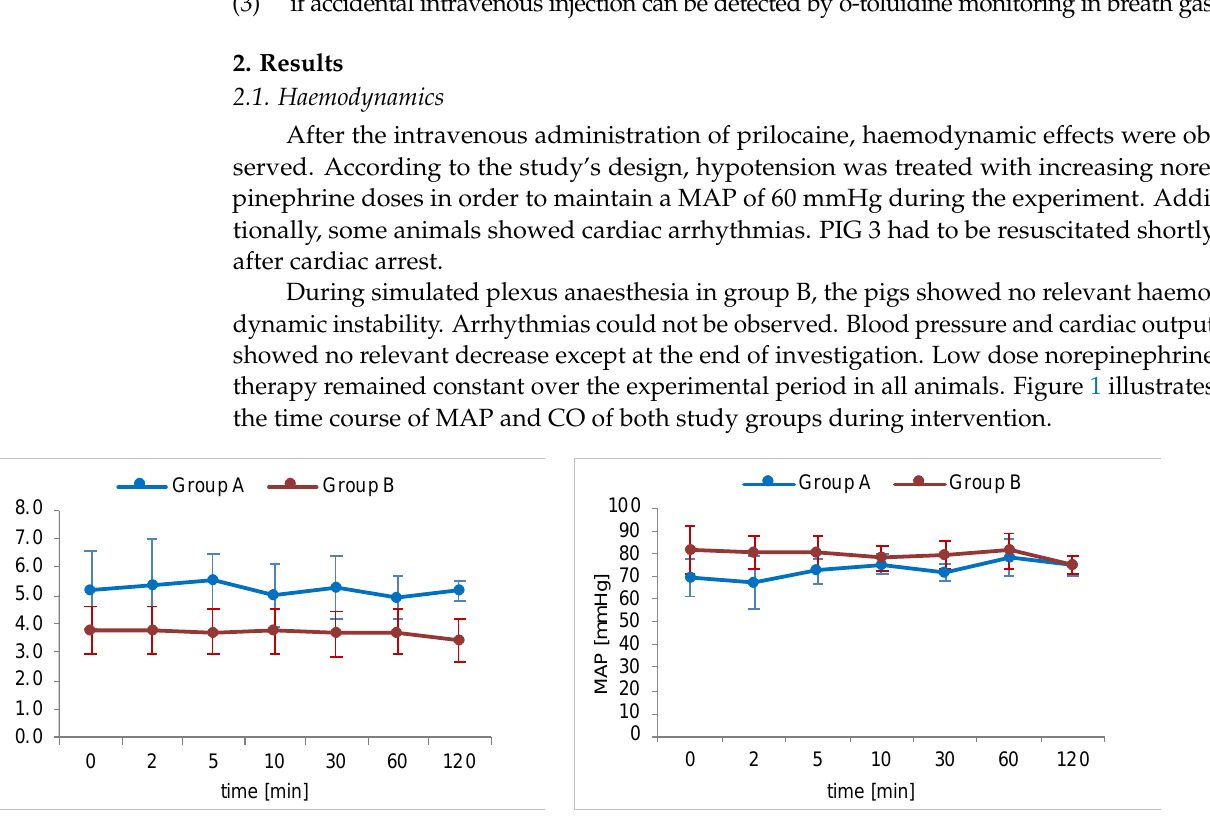
Figure 1. Time course of haemodynamic parameters mean arterial pressure (MAP) and cardiac output (CO). Blue lines represent group A (intravenous injection of prilocaine, n = 6) and red lines represent group B (cervical plexus regional anaesthesia with prilocaine, n = 5). Dots mark the defined measurement points as mean value of the entire group with relevant SD